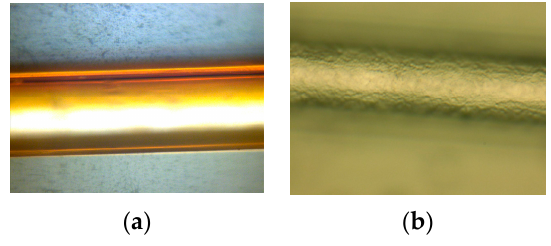
Figure 3. ( a ) Polyimide-covered UFBG; ( b ) Pd/Ni-covered UFBG.